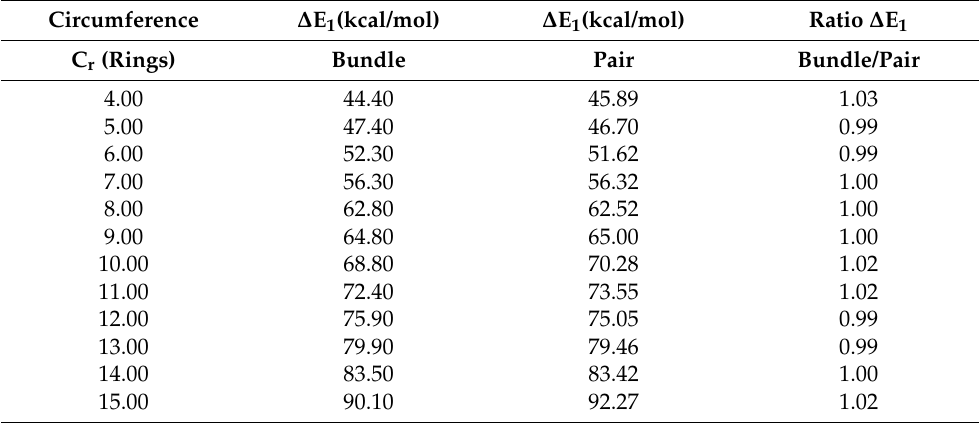
Table 1. CNT–CNT binding-energy values, ∆ E 1 (kcal/mol), from CNT bundles and CNT pairs as circumference of component nanotube measured in rings (C r ) were varied. Ratio of ∆ E 1 values obtained from bundles and from simple pairs indicates agreement between methods.